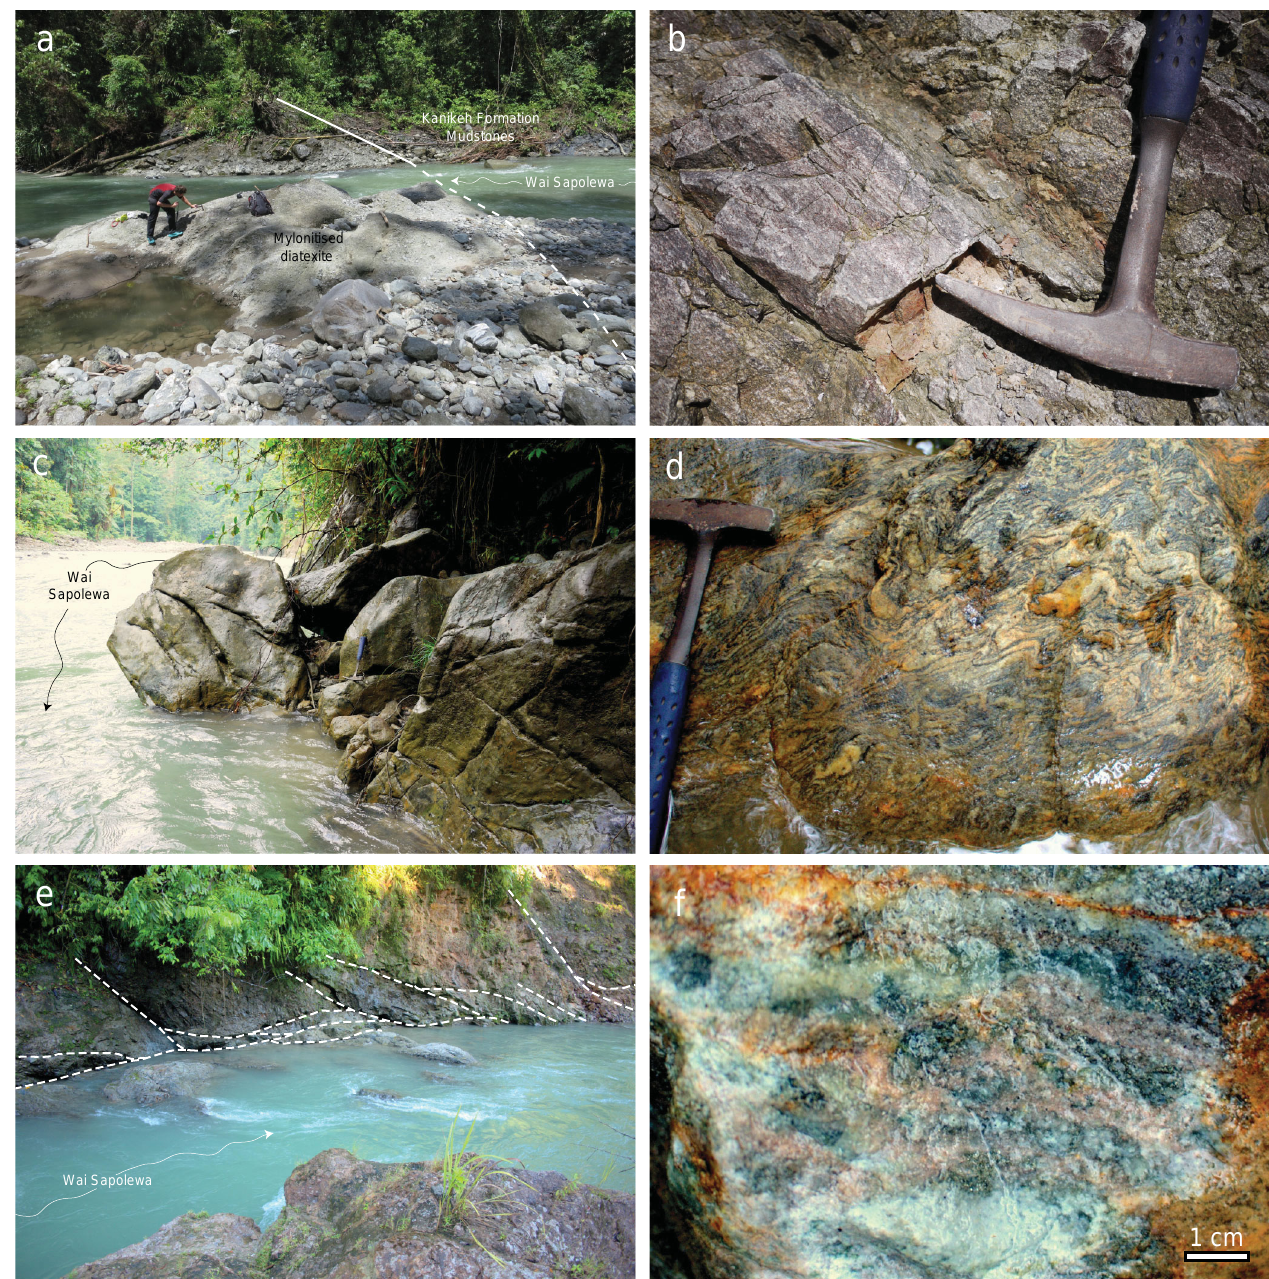
Fig. 16. The Wai Sapolewa, Kobipoto Mountains. (a) Mylonitised diatexite faulted beneath siltstones near the juncture of the Wai Wa (129.4530 ◦ E, 3.0201 ◦ S); (b) Close-up of the granulites shown in photo (a) displaying compositional banding between garnet+cordierite- rich and quartzofeldspathic domains; (c) In situ lherzolites exposed in the Wai Sapolewa near the junction with the Wai Sahoku (129.4456 ◦ E, 3.0285 ◦ S). See Fig. 18f for thin section; (d) Deformed stromatic metatexite boulder from the Wai Sahoku (129.4422 ◦ E, 3.0282 ◦ S); (e) Low- angle faults within a large exposure of high-temperature granulite facies gneisses by the Wai Sapolewa (129.4454 ◦ E, 3.0303 ◦ S) adjacent to the lherzolites shown in photo (c) ; (f) Garnet-rich granulite from the outcrop shown in photo (e) .